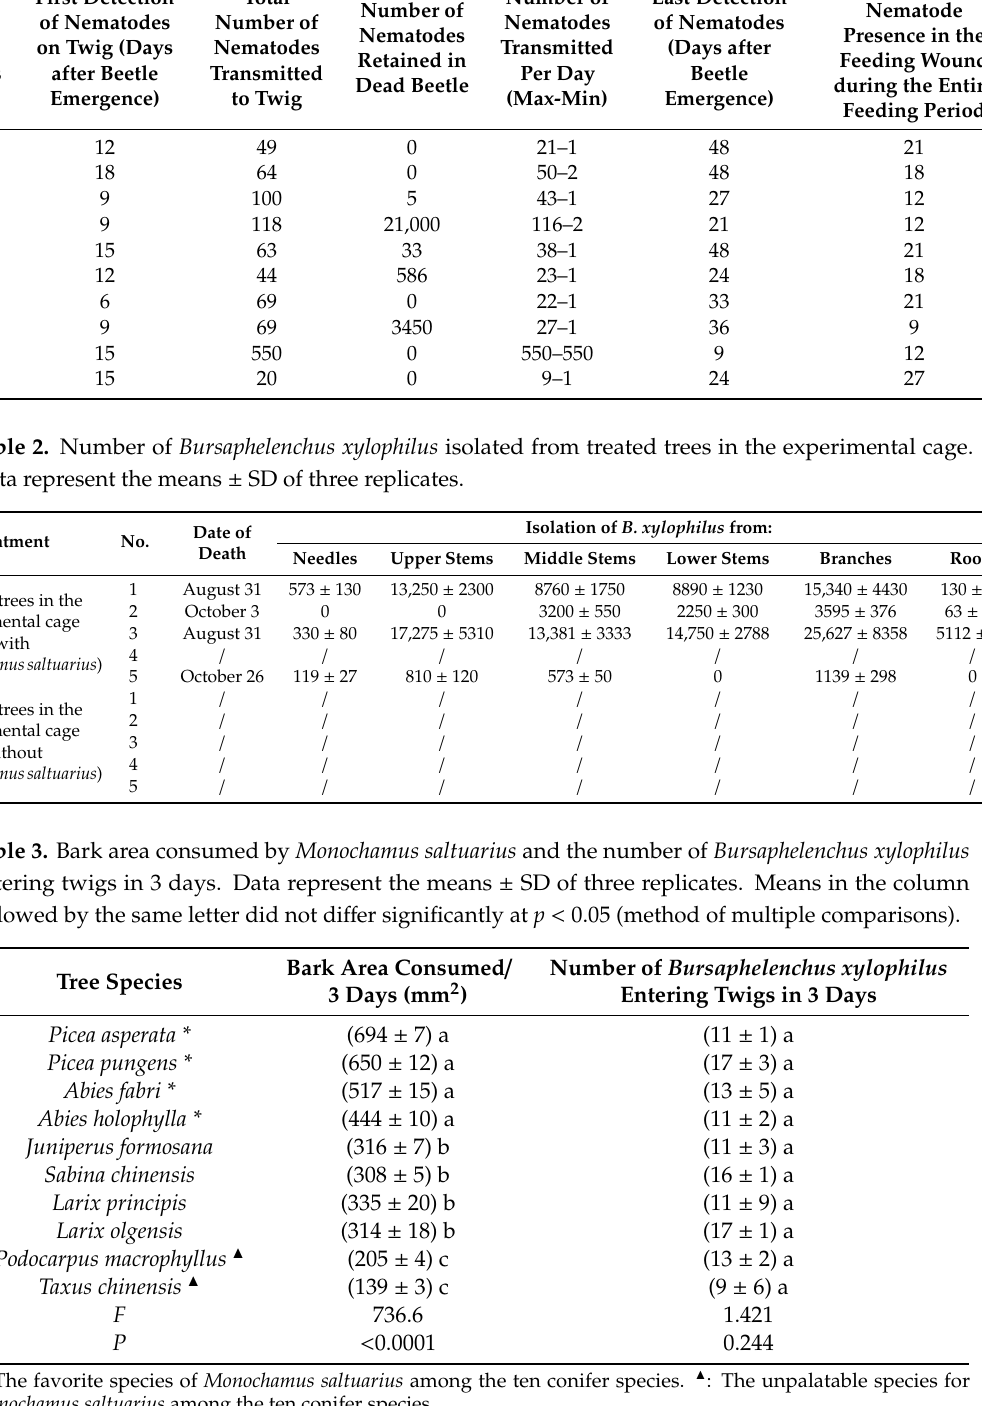
Table 1. Summary of Bursaphelenchus xylophilus transmission by several Monochamus saltuarius individuals feeding on twigs of Pinus koraiensis during the entire feeding period.